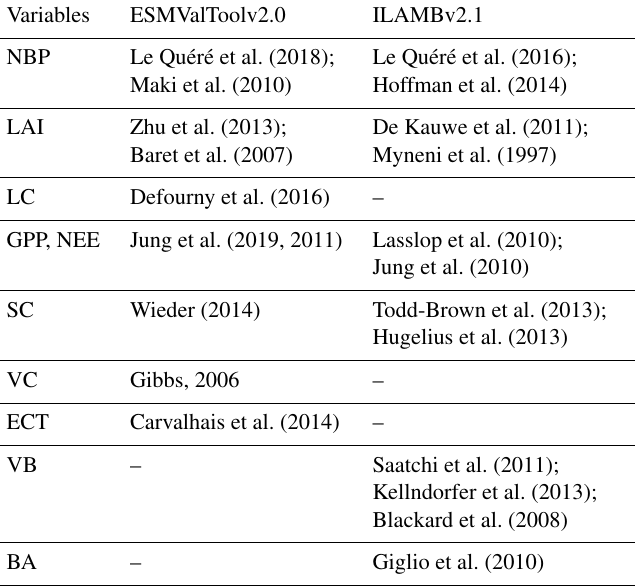
Table 6. Select observation-based reference dataset sources for ESMValToolv2.0 (Eyring et al., 2020) and ILAMBv2.1 (Collier et al., 2018), including net biome production (NBP), leaf area index (LAI), land cover (LC), gross primary production (GPP), net ecosystem exchange (NEE), soil carbon (SC), vegetation carbon (VC), ecosystem carbon turnover (ECT), vegetation biomass (VB), and burned area (BA). Note that vegetation carbon is dependent upon vegetation